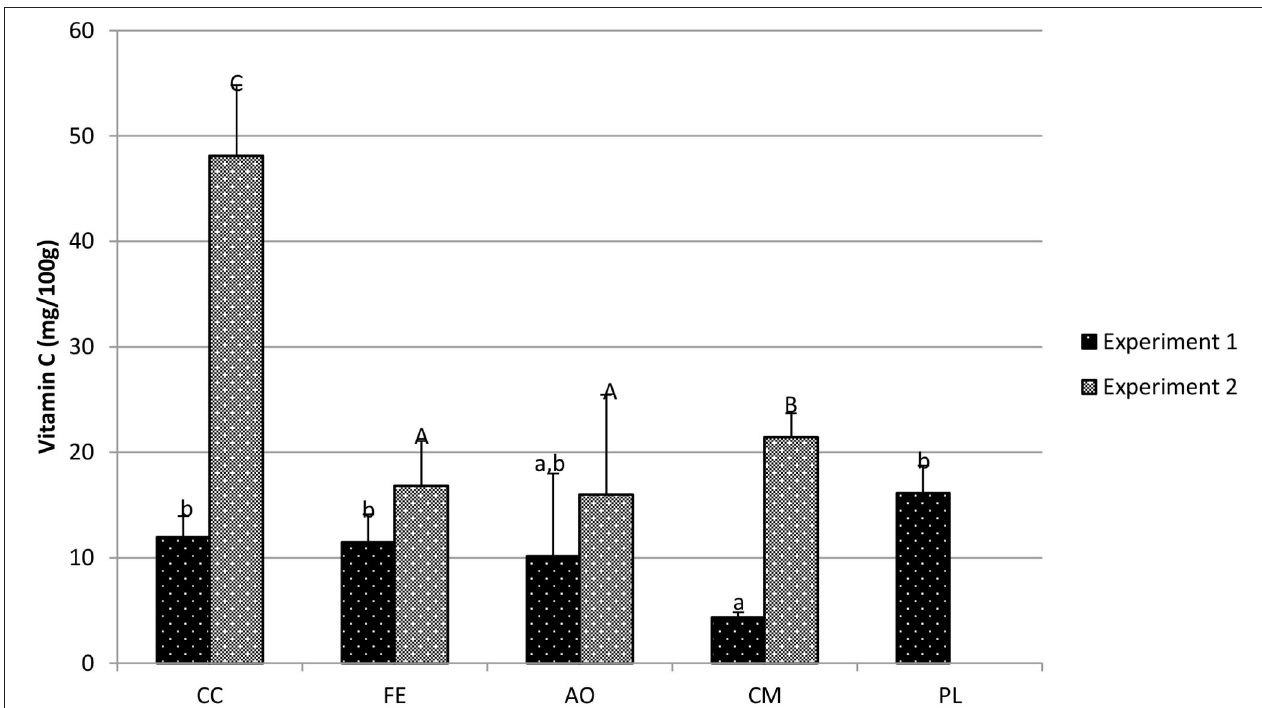
FIGURE 5 | Mizuna vitamin c concentration (mg/100g fresh weight) in harvested biomass—experiment 1 and experiment 2. Data shown are mean ± standard deviation for two different replicate experiments. Significant differences among mean values are indicated with different letters above bars ( p < 0.05) with lower-case letters for experiment 1 and capital letters for experiment 2. Results analyzed using ANOVA Tukey HSD for significance